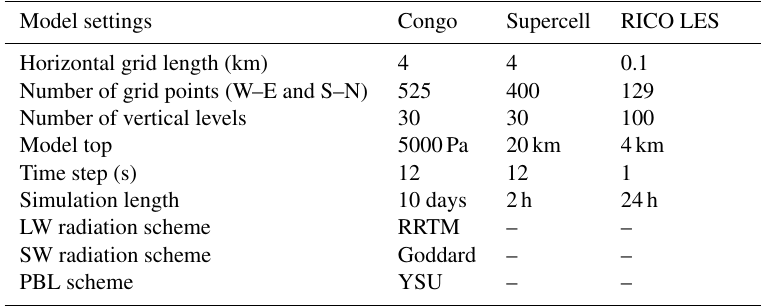
Table 1. List of model configurations.